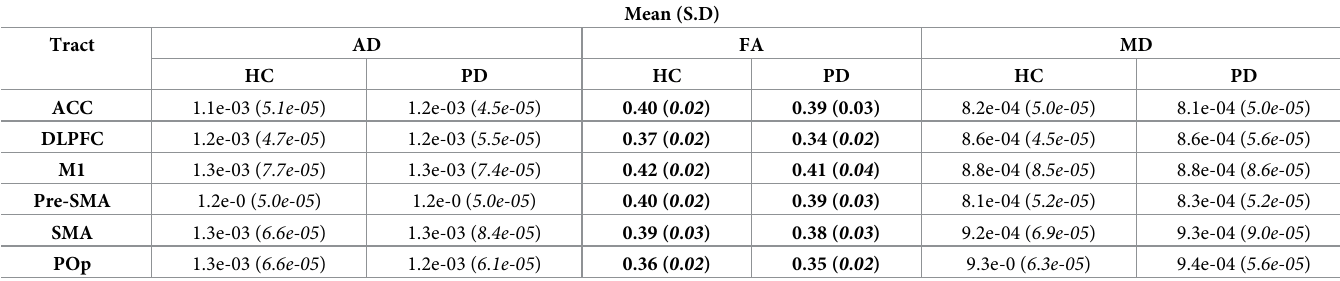
Table 4. Diffusion tensor imaging (DTI) descriptive statistics of axial diffusivity, fractional anisotropy and mean diffusivity per tract, per group.